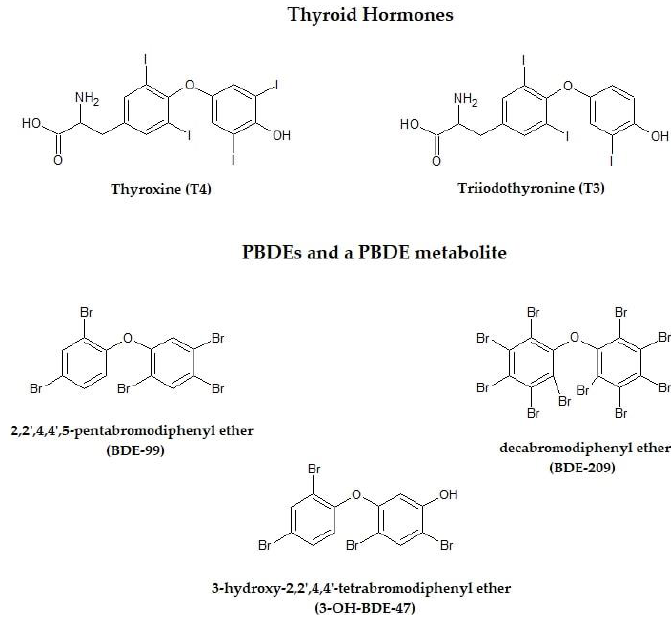
Figure 1. Chemical structures of thyroid hormones thyroxine and triiodothyronine and the main polybrominated diphenyl ethers (PBDEs) (modified from [16]).